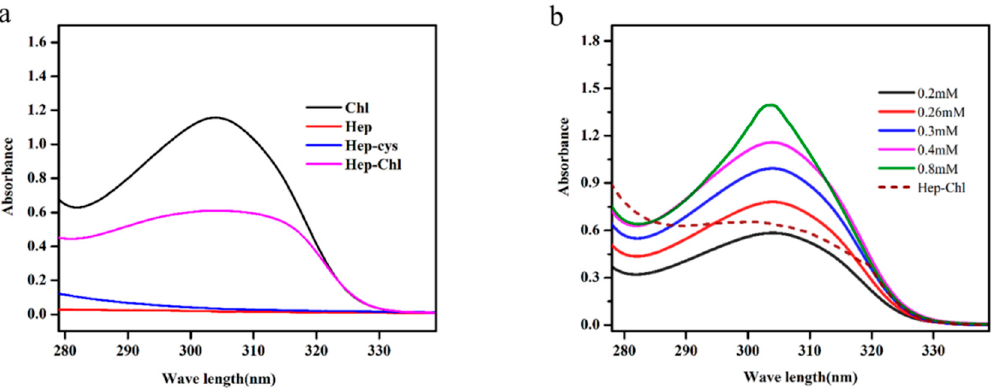
Figure 2. Raman spectra of heparin (Hep), chlorambucil (Chl), cystamine dihydrochloride (Cy), and the conjugate Hep–Cy–Chl.